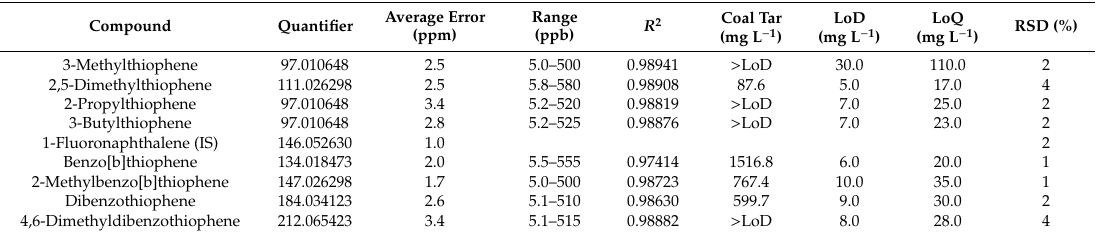
Table 3. Pure standard compounds, quantifier ions, average mass accuracy errors, calibration ranges, coe ffi cients of determination ( R 2 ), coal tar SAH concentrations, LoDs, LoQs, and